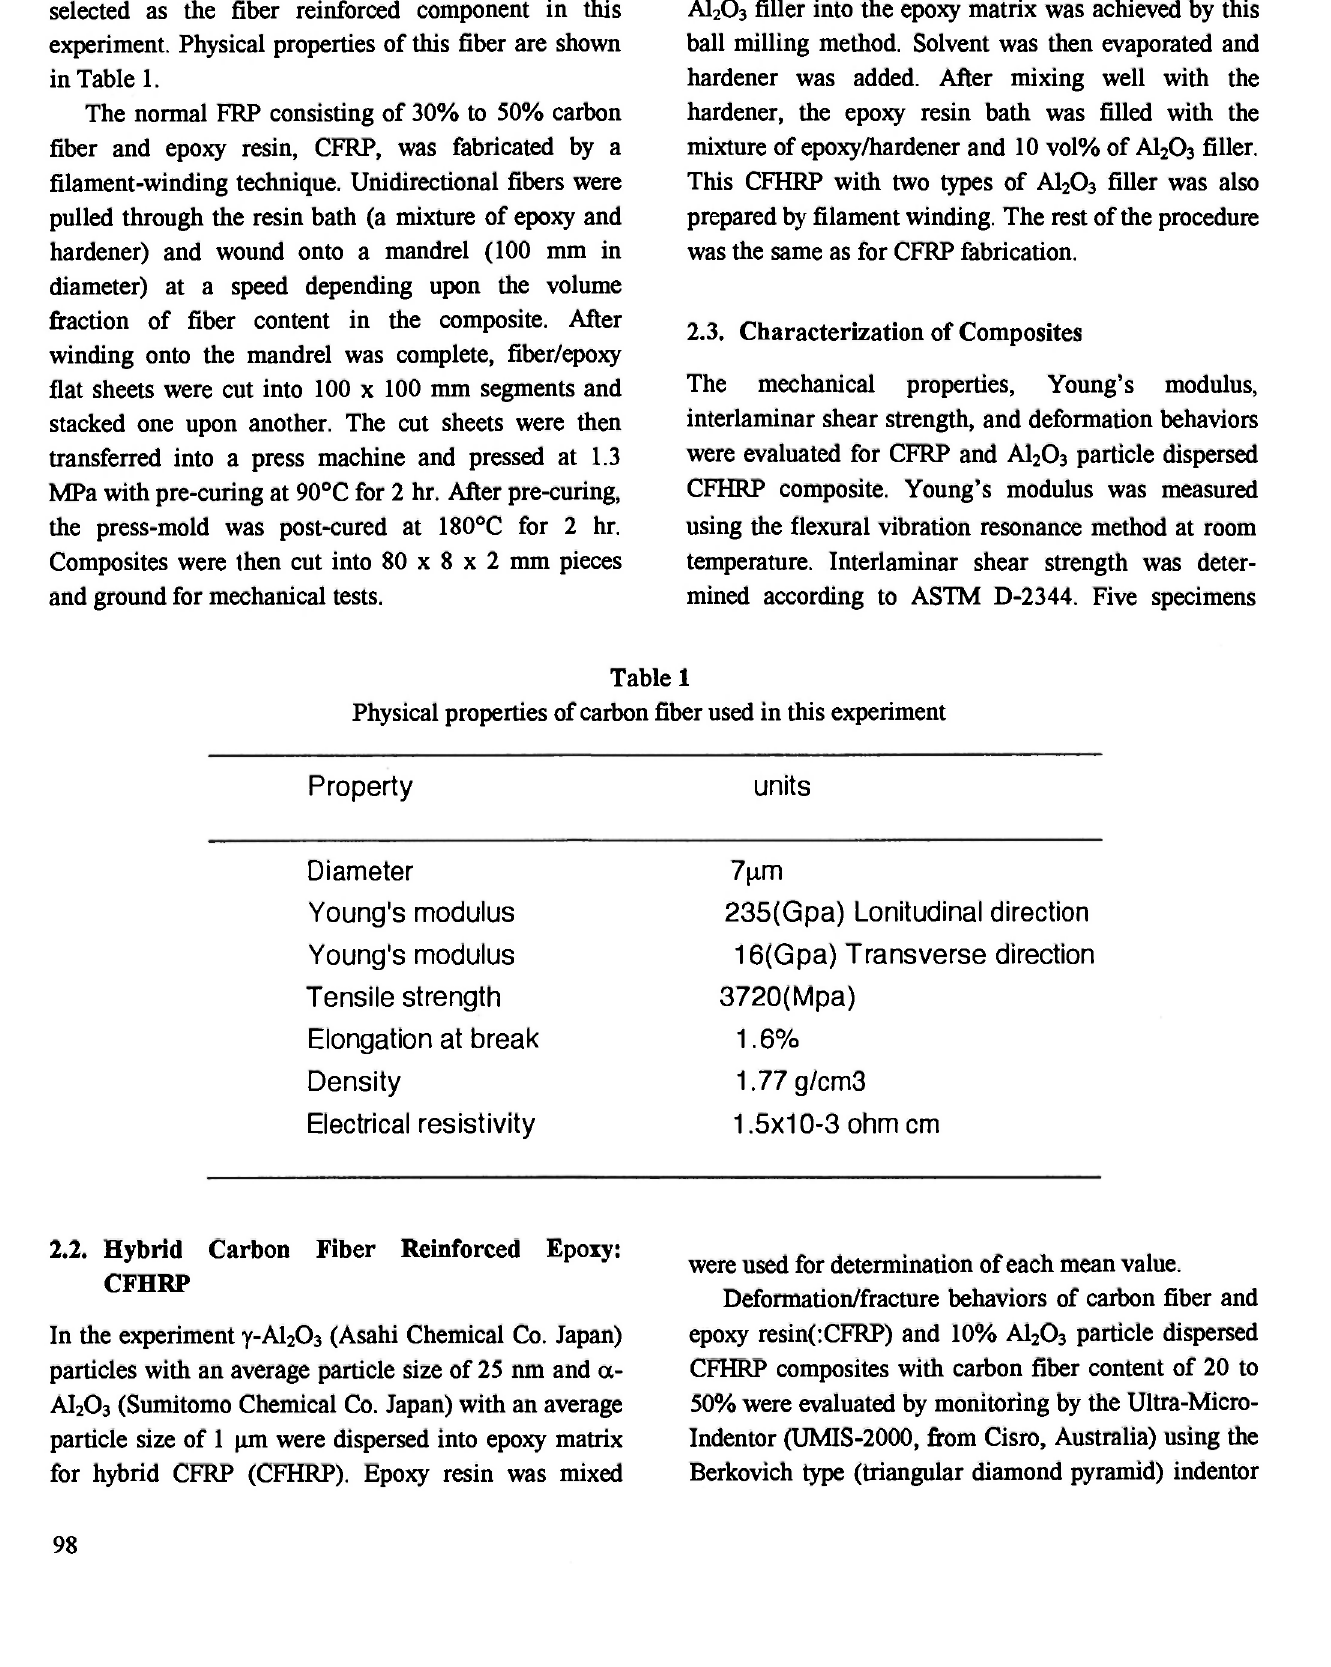
Physical properties of carbon fiber used in this experiment